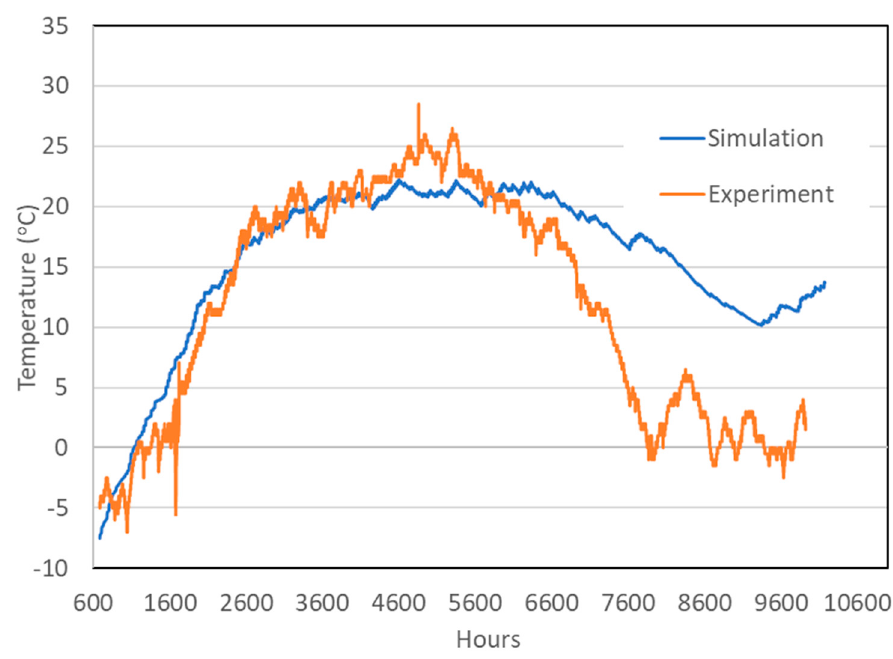
Figure 14. Fourteen-week thermal storage temperature profile by soil type.